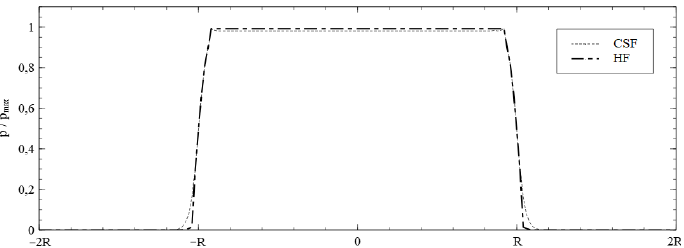
Figure 9. Comparison between analytically calculated Young-Laplace pressure, and numerically evaluated pressures around the bubble for the continuous surface force (CSF) model and the height function (HF)